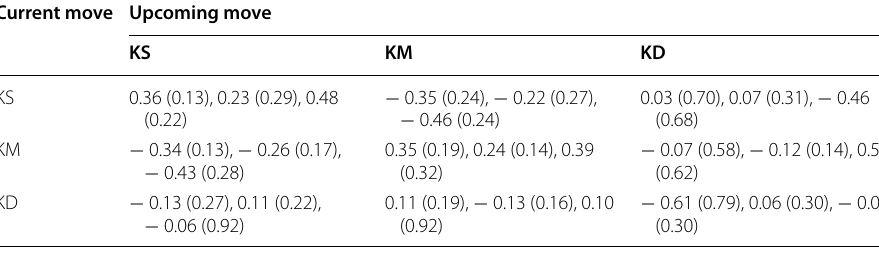
The values are shown as Mean (SD)